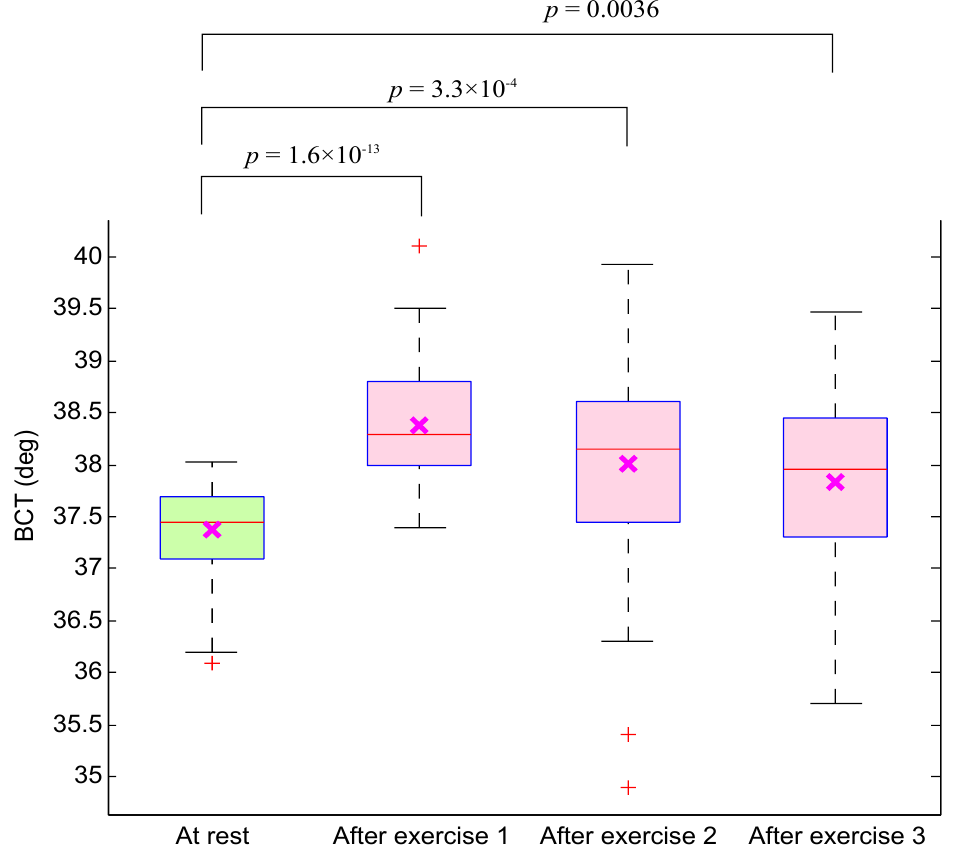
Figure 4. Boxplot of body core temperature (BCT) for subjects measured before and after exercise. The p -value was calculated using the paired Mann–Whitney